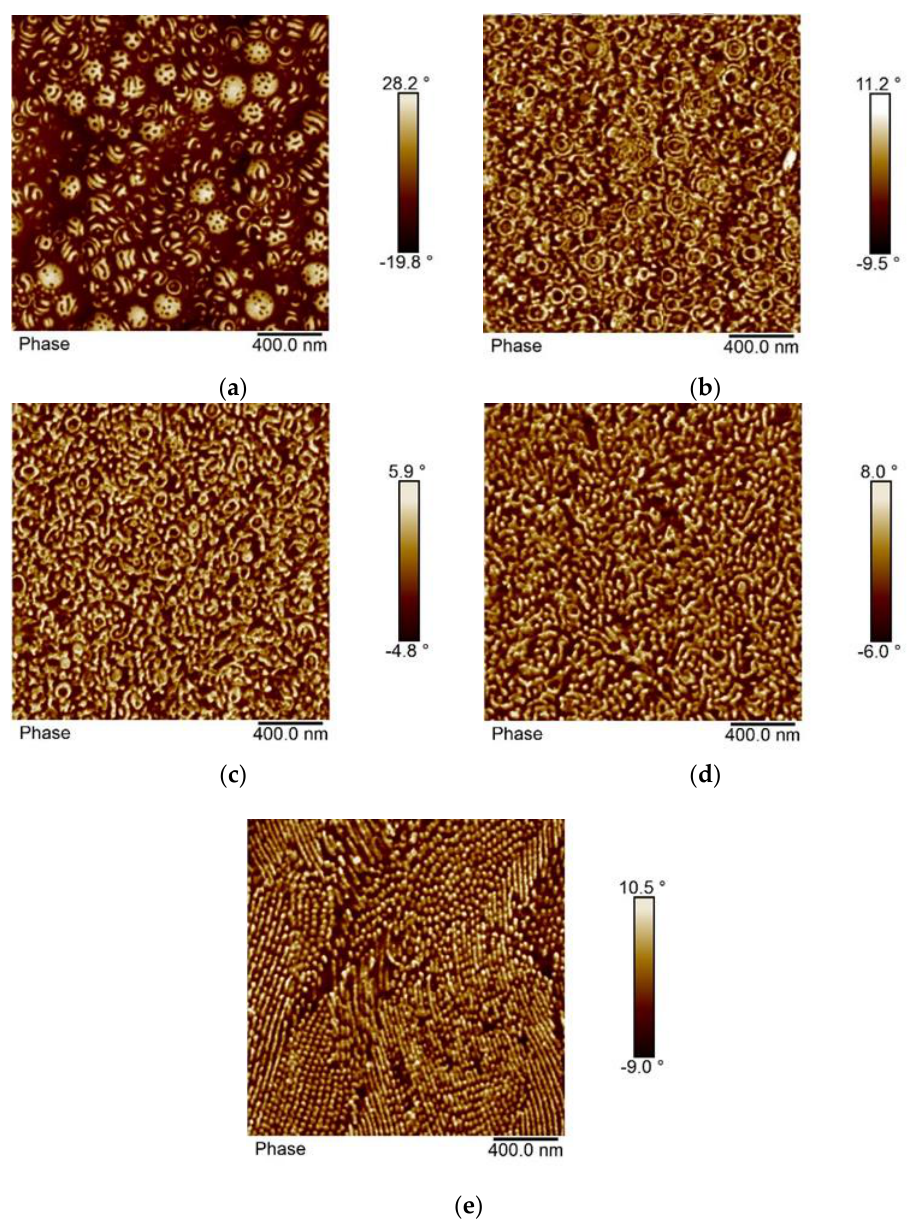
Figure 7. AFM phase images of the sample p(St30/2EHA50). ( a ) Top surface of the latex film dried at room temperature; ( b ) cross-section of the latex film dried at room temperature; ( c ) cross-section of the latex film dried at room temperature and annealed at 100 °C for 30 min; ( d ) cross-section of the latex film dried at room temperature and annealed at 100 °C for 96 h; and ( e ) cross-section of a film cast from THF solution.